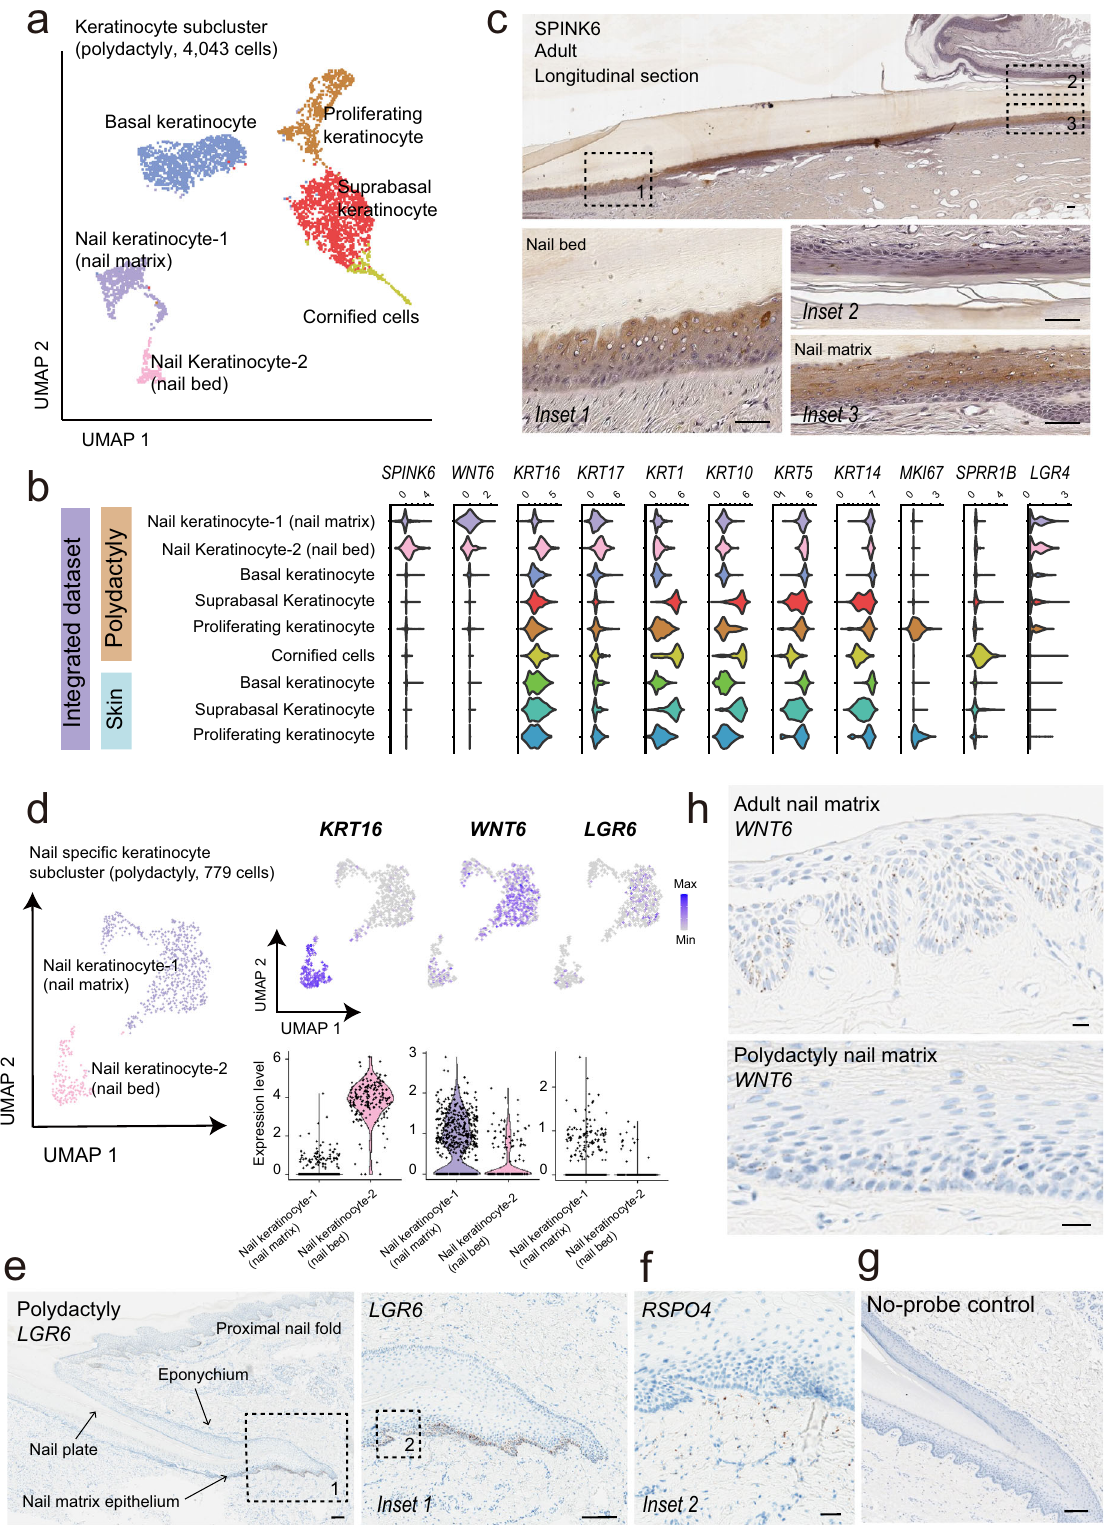
1000 ng/ml treated NMKs versus control NMKs (Supplementary Fig. 8). There was no signi fi cant difference in LGR6 expression. Comparison of human nail unit with human hair follicle . To gain a deeper understanding of nail biology, we compared